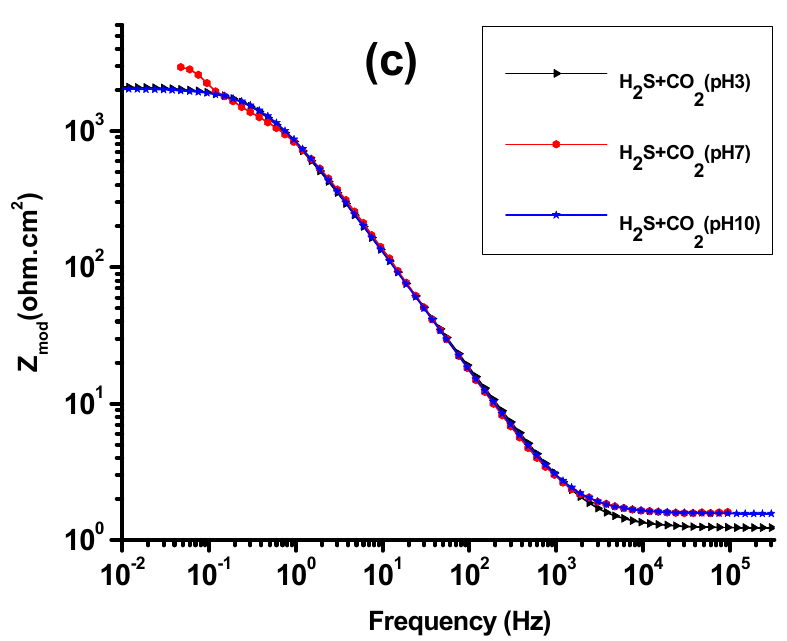
Figure 2. Bode magnitude plots in different solutions with different pH values: ( a ) 3.5% NaCl + CO 2 , ( b ) 3.5% NaCl, and ( c ) CO 2 + H 2 S solution.